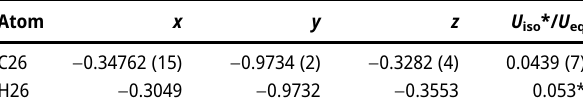
Table  : Fractional atomic coordinates and isotropic or equivalent isotropic displacement parameters (Å 